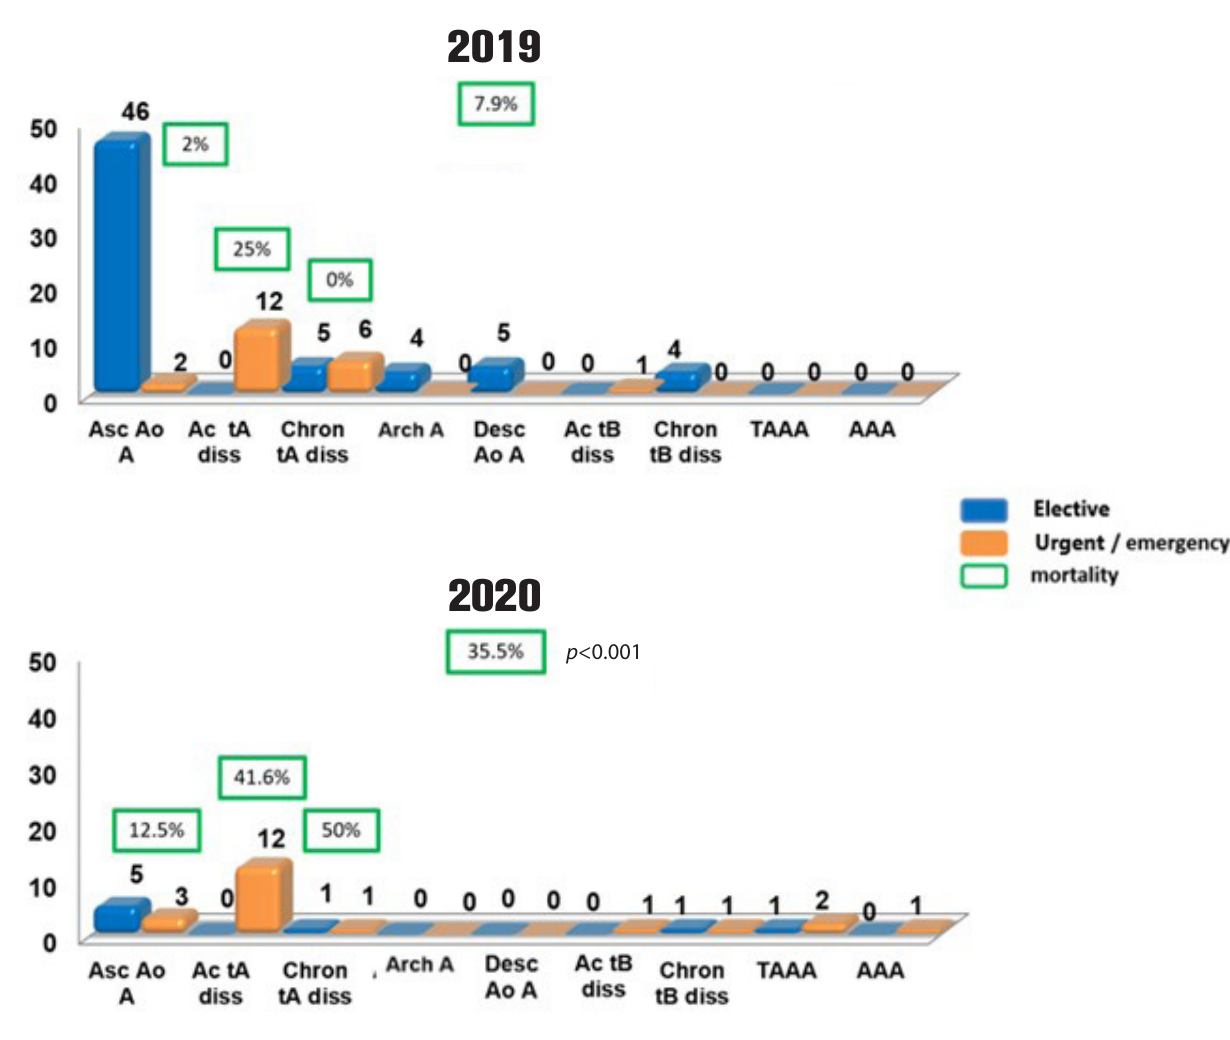
Fig. 1 - Number of patients operated on based on their diagnosis of aortic disease. In green, the general and specific hospital mortality during the studied period, in the three most common performed operations. AAA=abdominal aortic aneurysm; Arch A=arch aneurysm; Ac tA diss=acute type A aortic dissection; Ac tB diss=acute type B aortic dissection; Asc Ao A=ascending aortic aneurysm; Chron tA diss=chronic type A aortic dissection; Chron tB diss=chronic type B aortic dissection; Desc Ao A=descending aortic aneurysm;